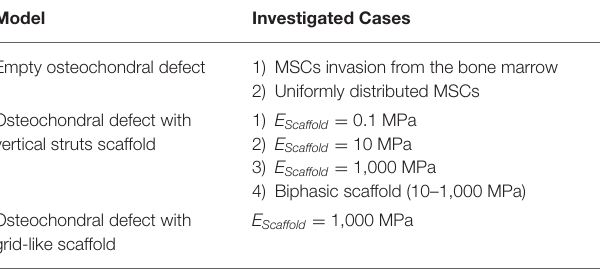
TABLE 2 | List of models and corresponding investigated